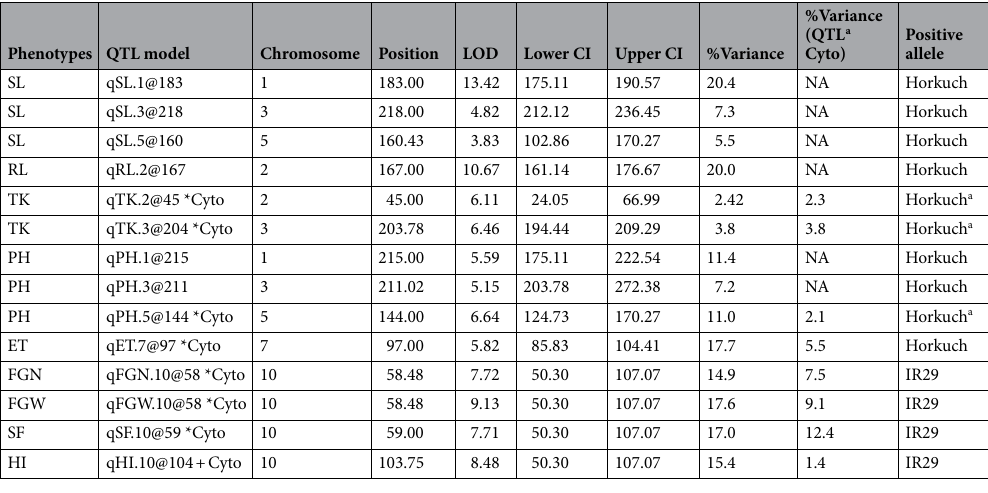
Table 1. Estimated QTL models: effect and localization. Each QTL model was built by linear mixed model using kinship matrix as a covariate. Asterisk sign denotes interaction with cytoplasm whereas (+) sign denotes only additive cytoplasmic effect in the QTL model. a Denotes QTL that has both main and interaction effect since only considering direction of the main effect can be